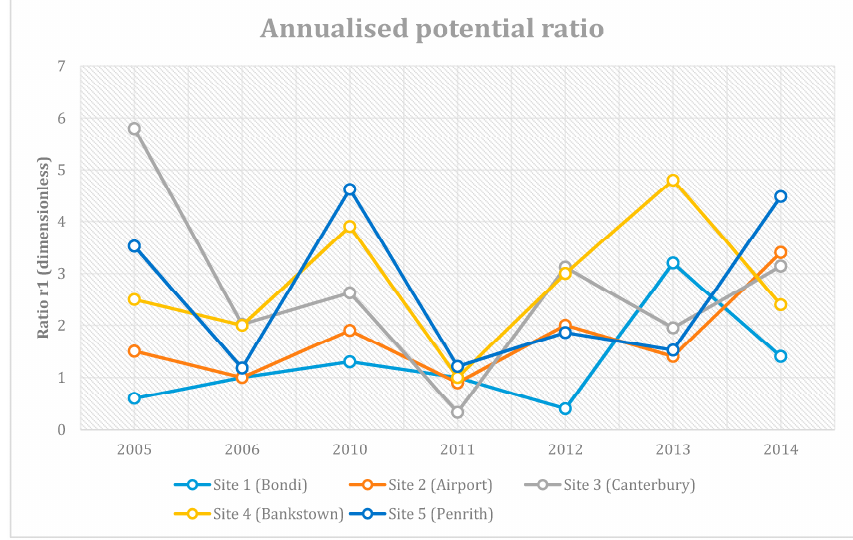
Figure 6. Annualised potential ratio R1 for the Sydney sites for each simulation year.